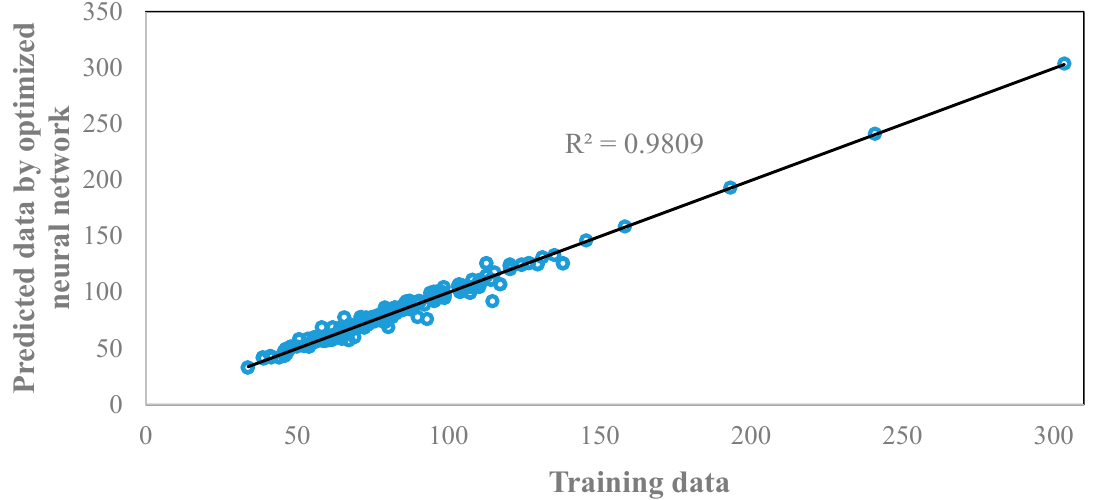
Figure 11. The correlation coefficient of the predicted data by optimized ANN structure and training data.